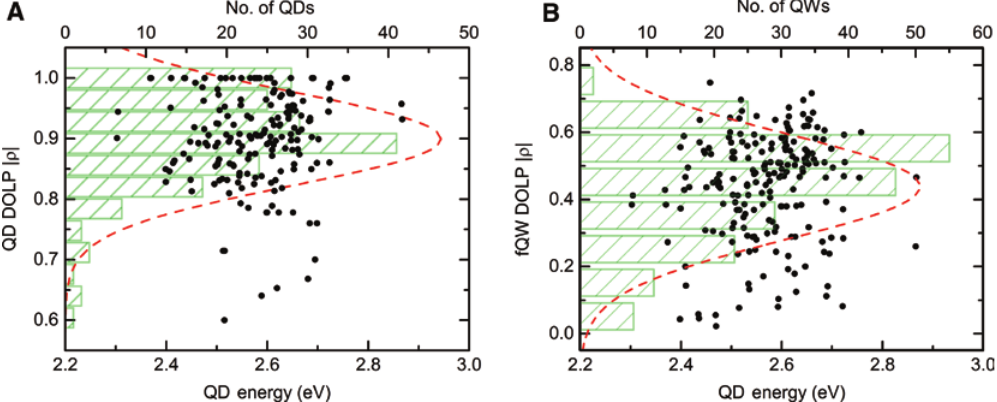
Figure 4: The 180 a -plane InGaN/GaN (A) QD and (B) underlying QW DOLP variation with emission energy. The statistical distributions have been fitted with Gaussian profiles. The means and standard deviations of the Gaussian distributions are (A) 0.90 ± 0.08 and (B) 0.46 ± 0.14,